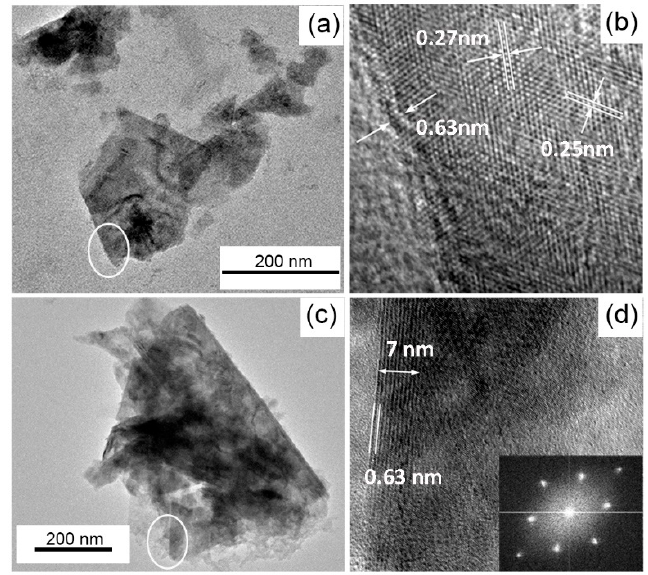
Figure 3. ( a , c ) TEM of 2 h ball milled and 90 min sonicated WS 2 , ( b ) HRTEM corresponding to the circled area shown in figure ( a ) with highlighted the interlayer distance (0.63 nm) and lattice spacing (0.27 nm and 0.25 nm), corresponding to (100) and (101) planes of WS 2 respectively, ( d ) HRTEM of the edge of the flake corresponding to the circled area shown in figure ( c ) with highlighted the 7 nm thick edge corresponding to 11 layers. The inset shows the Selected Area Electron Diffraction (SAED) of the flake.